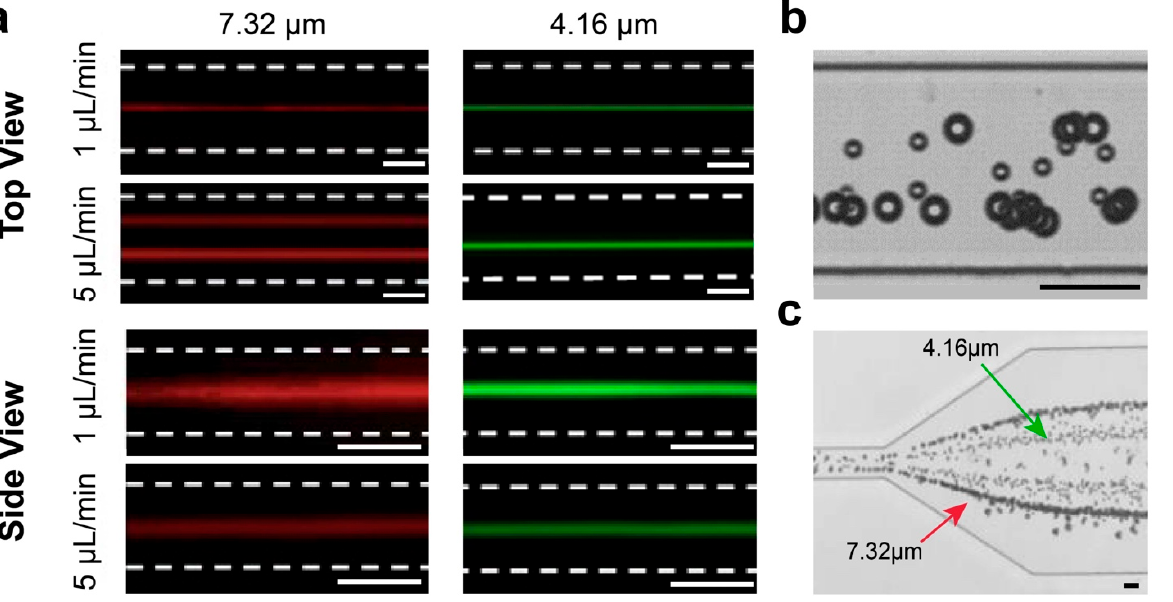
Figure 4. Experimental observations of focusing and separation of the 4.16 µm and 7.32 µm diameter particles in viscoelastic flow. ( a ) Fluorescent streak images of top and side views at 1 µL/min ( Wi = 3.6) and 5 µL/min ( Wi = 18) in 50 µm × 25 µm microchannel. ( b ) Top view bright-field image confirming distinct focusing positions of the two particle sizes at Q = 5 µL/min. ( c ) Expansion region at the channel outlet enabling separation of the focused streams. (Scale bar in all images: 25 µm).